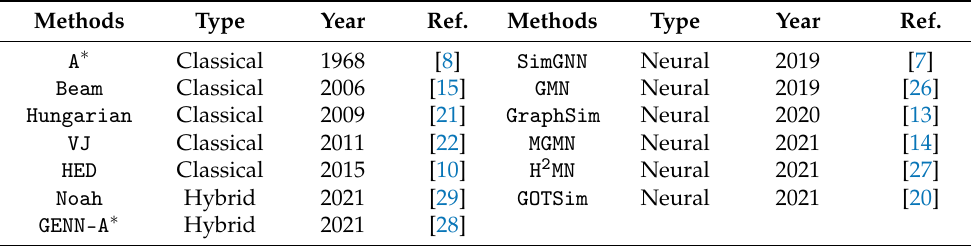
Table 1. Summary of existing graph similarity computation methods. The Type column represents the type of the method, which can be classical, neural, or hybrid. Year refers to the publication year, and Ref. provides the